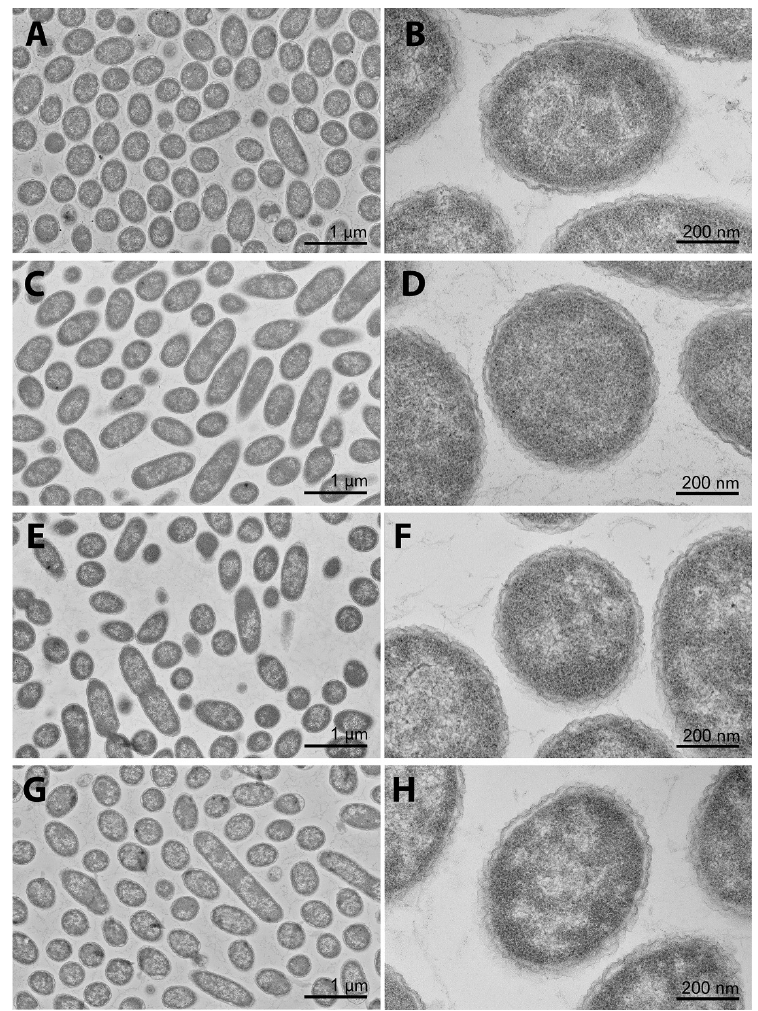
Figure 4. Representative TEM images, taken after 60 min with and without chlorhexidine treatment of the wild-type and ∆ cpxR mutant of S . Enteritidis, respectively. Images ( A,B ) portray wild-type cells with no chlorhexidine treatment, while images ( C , D ) show wild-type cells during the chlorhexidine treatment. Similarly, images ( E , F ) depict the ∆ cpxR mutant during no treatment, whereas images ( G , H ) show the same organism during the chlorhexidine treatment.